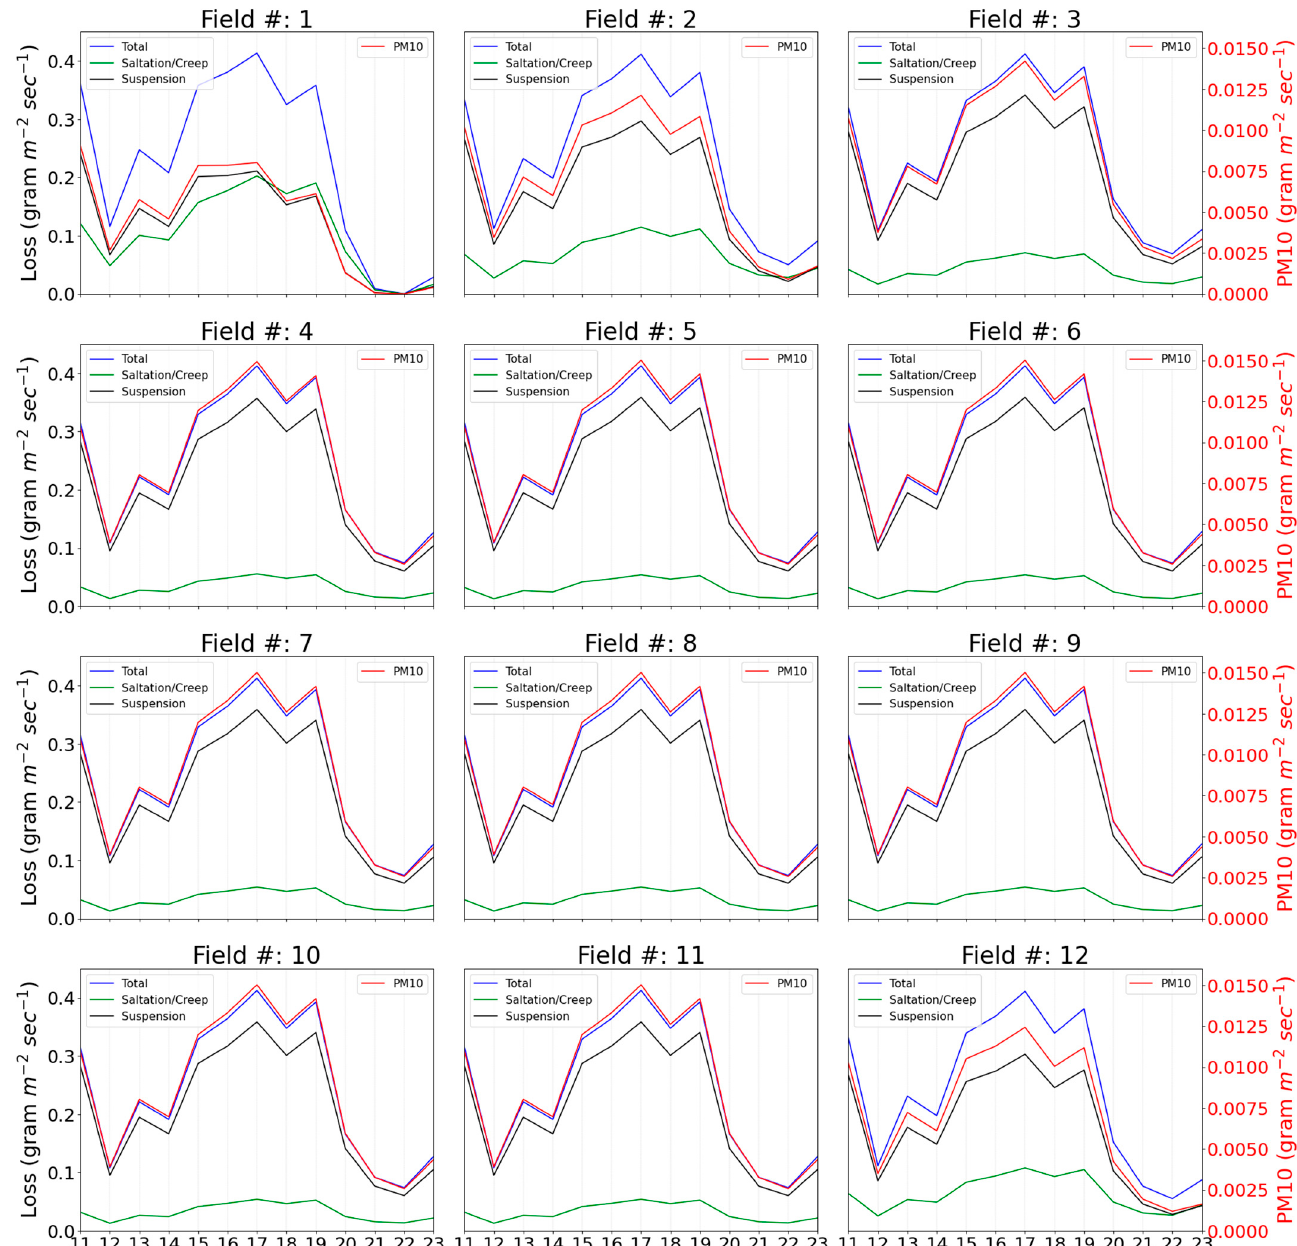
Figure 8. SWEEP simulated soil loss in terms of the total, saltation/creep, suspension, and PM 10 from the North Playa field during the dust event of 3 February 2020. The left y-axis represents the total, saltation/creep, and suspension loss, and the right y-axis (twin axis) represents PM 10 .